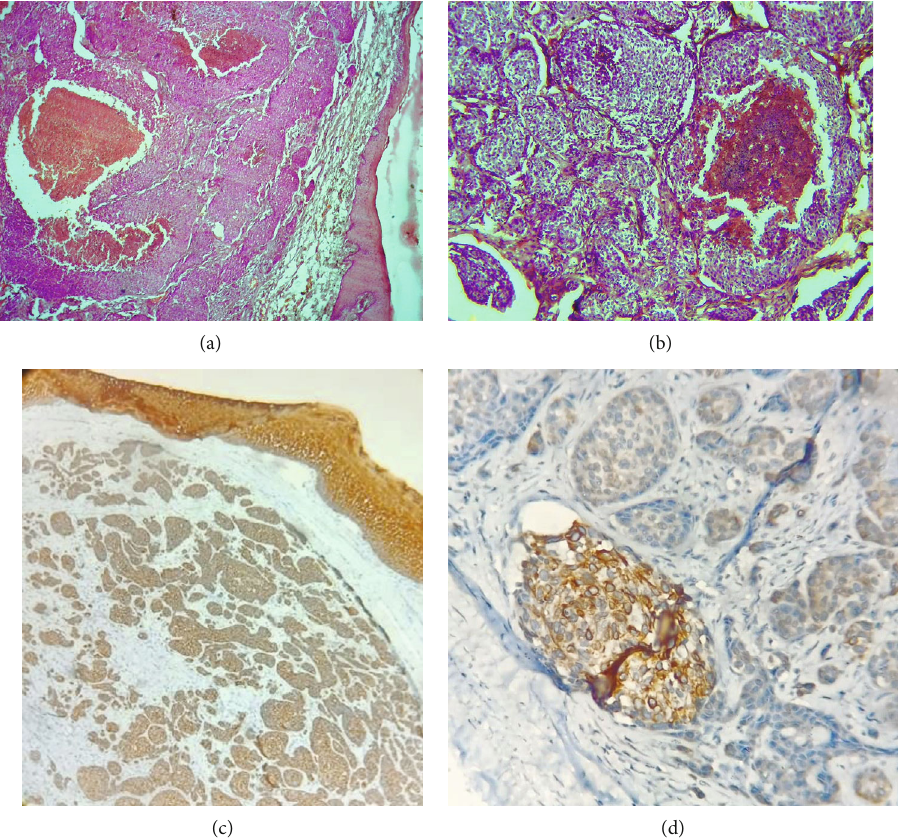
Figure 4: (a) Scanner view showing cohesive islands of tumour epithelial islands separated from the overlying surface epithelium by a grenz zone. Some tumour islands show central necrosis (4 × ); (b) Low power view shows cohesive islands of tumour epithelial islands and some tumour islands show central necrosis. (10 × ). (c) The surface epithelium and in fi ltrating epithelial tumour islands in the connective tissue were positive for Pan CK (4 × ). (d) IHC showing positive CK7